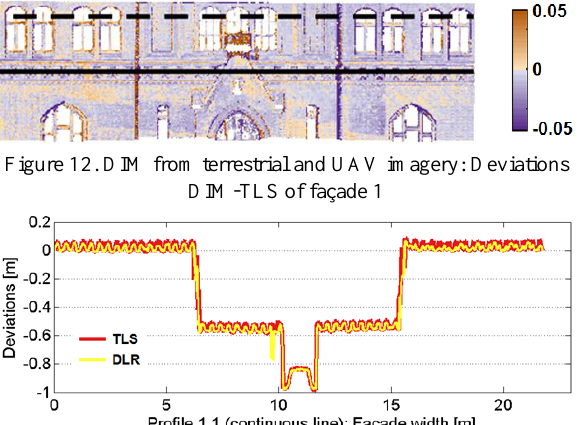
Figure 10. Horizontal profiles of façade 1